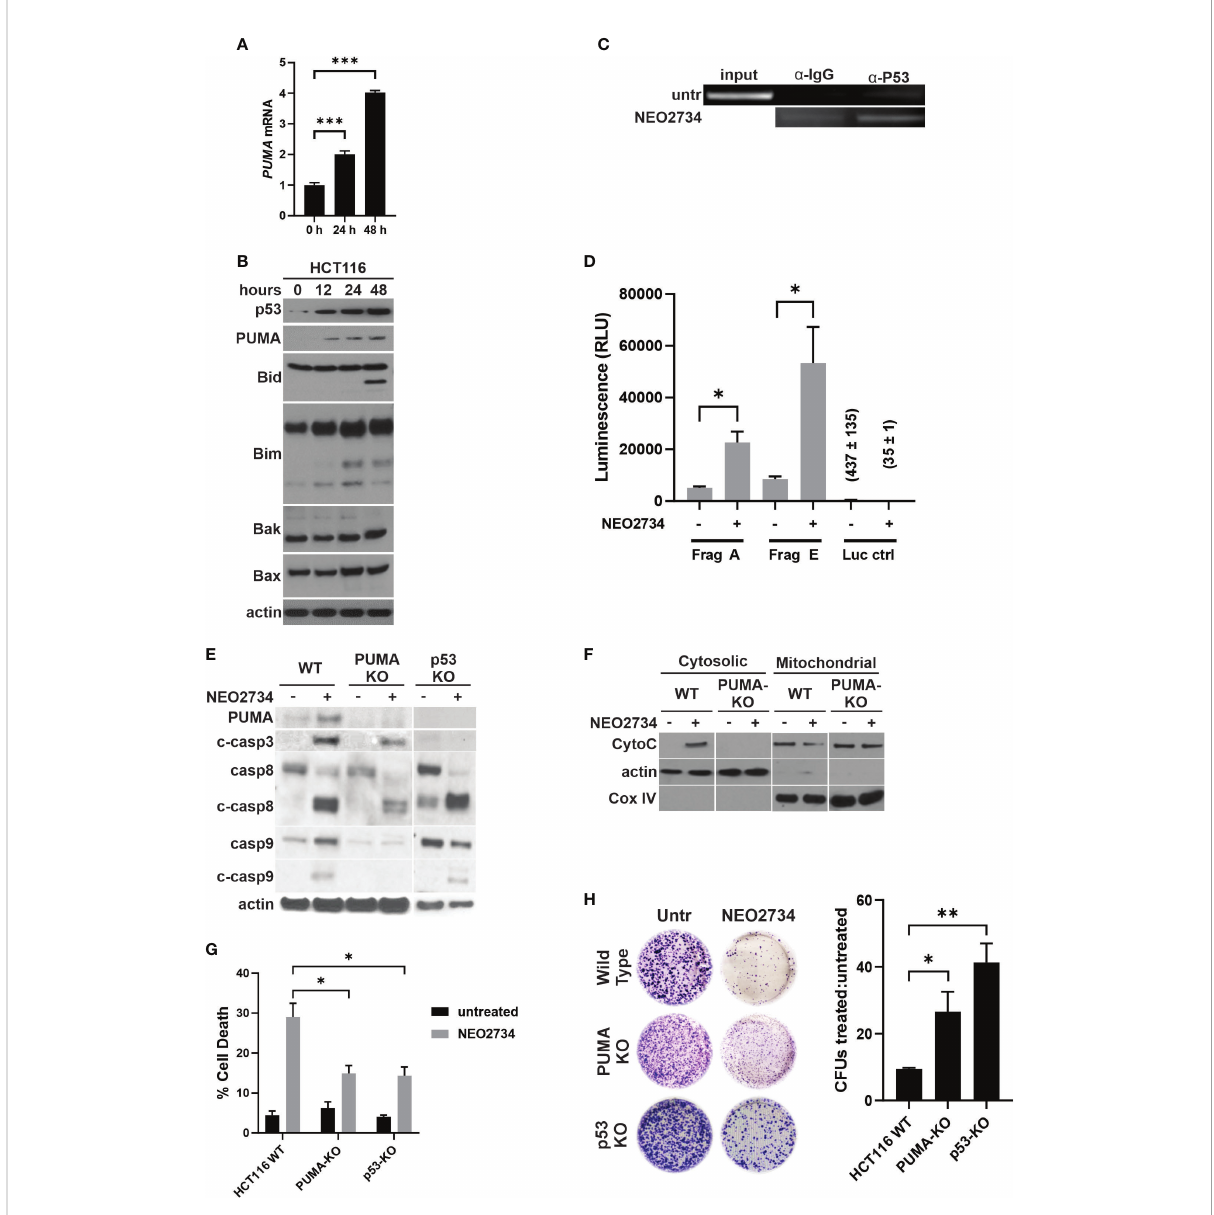
FIGURE 3 NEO2734 induces apoptosis through p53/PUMA. (A) RT-PCR of PUMA in HCT116 cells treated with NEO2734 10µM or DMSO for 24 h, normalized to GAPDH. (B) Western blot of p53 and PUMA in HCT116 cells treated for up to 48 hours with NEO2734 10µM or DMSO. (C) ChIP analysis of p53 binding to the PUMA promoter in HCT116 cells treated with NEO2734 10uM for 24 h, with rabbit IgG control IP. PUMA promoter was detected by PCR ampli fi cation of precipitated DNA fragments using primers fl anking the p53 binding site, followed by visualization on agarose gel electrophoresis. (D) Luciferase reporter assay of the p53/ PUMA promoter. HCT116 cells were transfected with pBV-based PUMA fi re fl y luciferase reporter plasmids as previously published (20), along with CMV- b gal plasmid. 24 hours after transfection, cells were treated with NEO2734 10µM or DMSO. 24 hours after drug treatment, cell lysates were prepared and luminescence was measured. Signals were normalized for cell viability as well as transfection ef fi ciency based on co-transfected b gal. (E) Western blot of PUMA and caspases in parental HCT116 (WT), HCT116 PUMA -KO, and HCT116 p53 -KO cells treated with NEO2734 10µM for 48 hours. (F) Western blot of cytosolic versus mitochondrial fractions of HCT116 WT and PUMA -KO cells treated with NEO2734 10µM for 48 hours, with antibodies against cytochrome C (CytoC) and cytochrome oxygenase IV (Cox IV). (G) Apoptosis percentage as measured by quanti fi cation of fragmented nuclei in HCT116 parental and knockout cells treated with NEO2734 10µM for 48 hours. (H) Crystal violet staining of colony formation assay of HCT116 parental and knockout cells treated with NEO2734 10µM for 24 h and then replated at 1:400 dilution. Bar graph represents ratio of colonies from NEO2734 treated cultures versus DMSO cultures treated in parallel, for 24 hours. Mean and S.D of 3 independent experiments are shown (*p < 0.05; **p < 0.005; ***p <